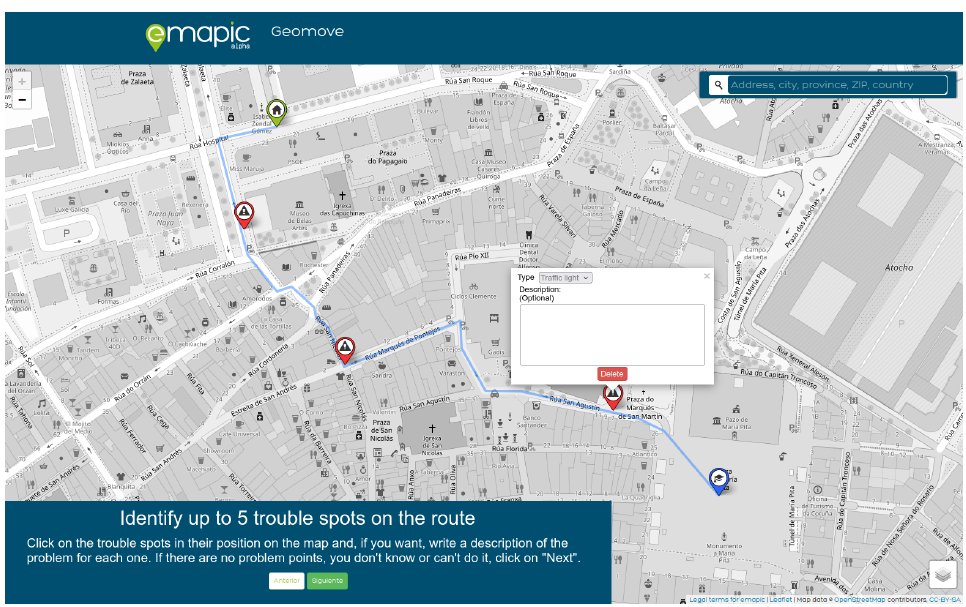
Figure 2. Digitization of the home–school route and location of problems in the